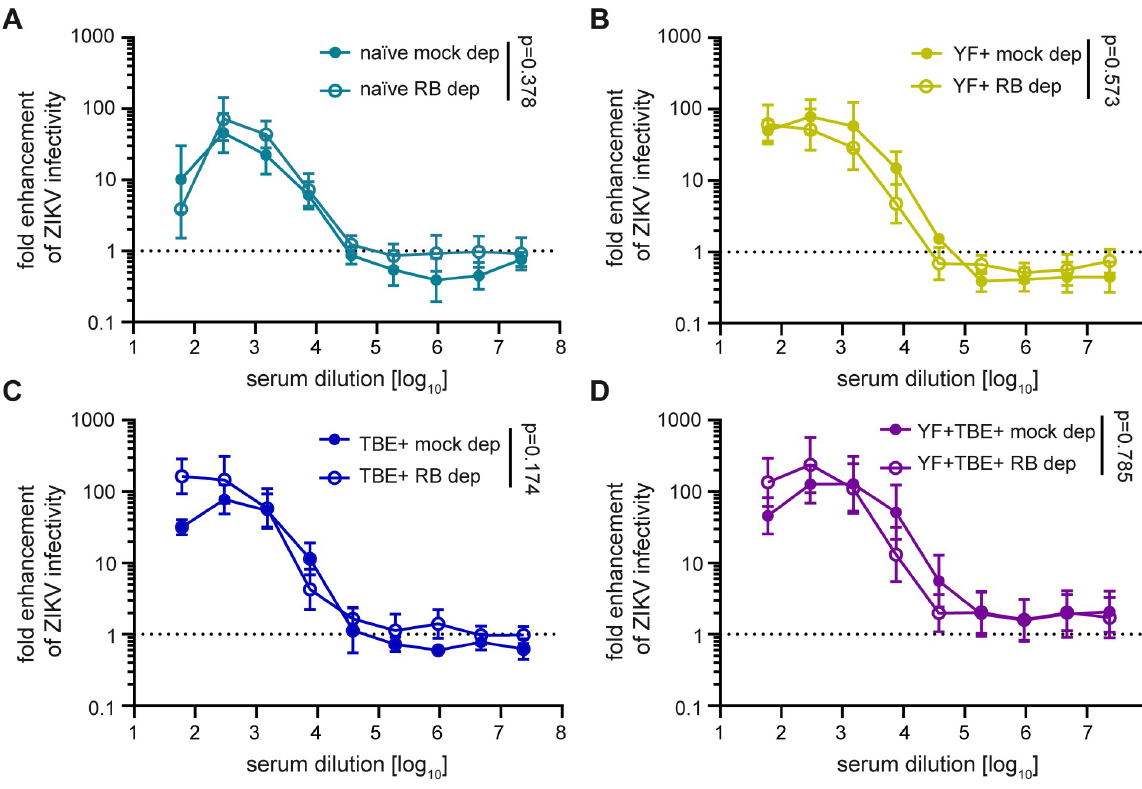
Fig 7. Effect of depletion of cross-reactive antibodies from serum pools with Rio Bravo virus E on ADE of Zika virus infection. Fc γ receptor- positive K562 cells were infected with Zika virus in the presence of serially diluted (A) flavivirus-na ï ve pool, (B) YF pre-vaccinated pool, (C) TBE pre-vaccinated pool, and (D) YF and TBE pre-vaccinated pool. IgG-containing serum pools were further depleted with RB virus E protein as described in Methods. Colored symbols: mock depletion, empty symbols: RB depletion. Data are shown as mean values +/- SEM from three independent experiments. Dotted line indicates no enhancement of infection. Comparison of fold-enhancement of Zika virus infection in the presence of depleted and mock-depleted pools was performed by applying a general linear model as described in Methods. p-values are indicated in the graphs. ZIKV, Zika virus; mock dep, IgM and mock-depleted serum pool; RB dep, IgM and Rio Bravo virus E-depleted serum pool.